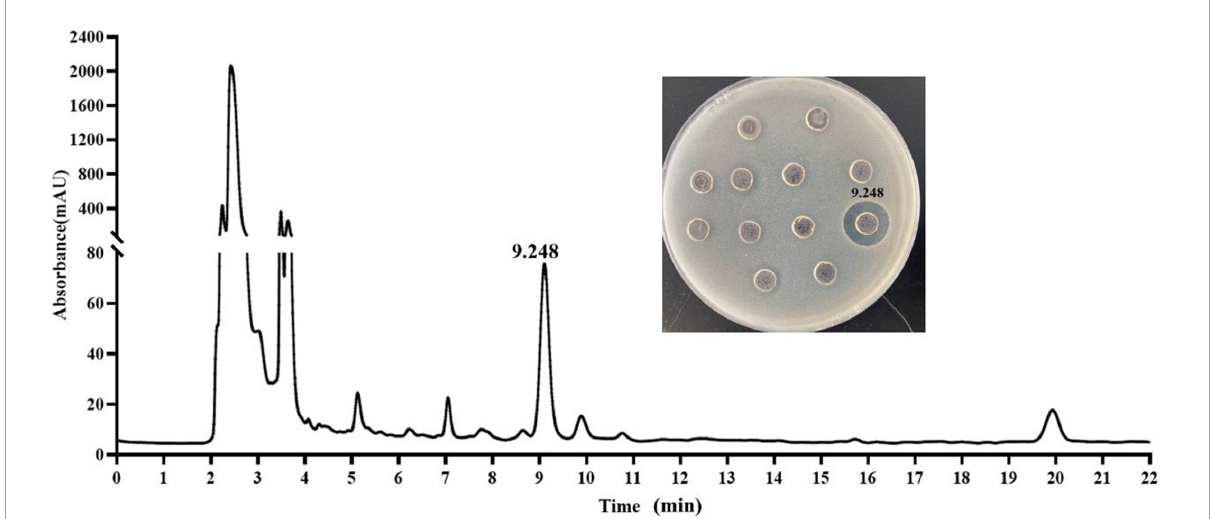
FIGURE4 Purification of the antimicrobial agent from the fraction C4 by C 18 -H column and determination of the antimicrobial activity of the peaks against E. coli ATCC 25922.